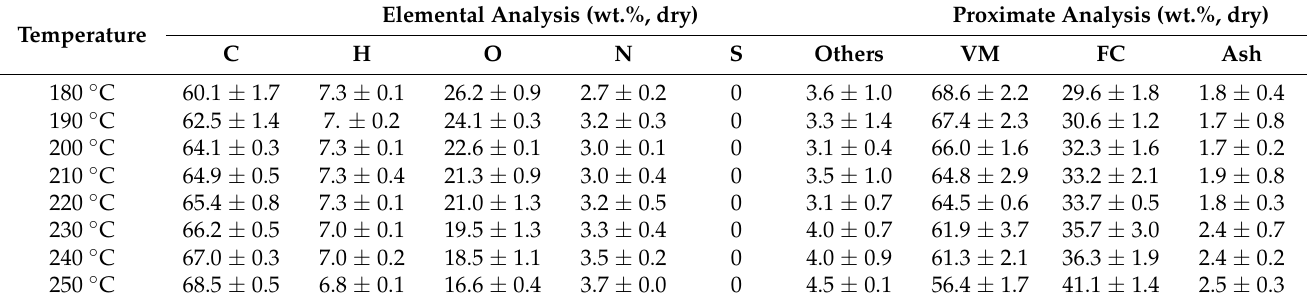
Figure 6. Oxygen and volatile organic compound (VOC) contents of SCGs produced with different reaction temperatures and water contents. Table 2. Elemental and proximate analysis of SCGs hydrothermally carbonized with different reaction temperatures (SGC: water = 1:1.5). Temperature